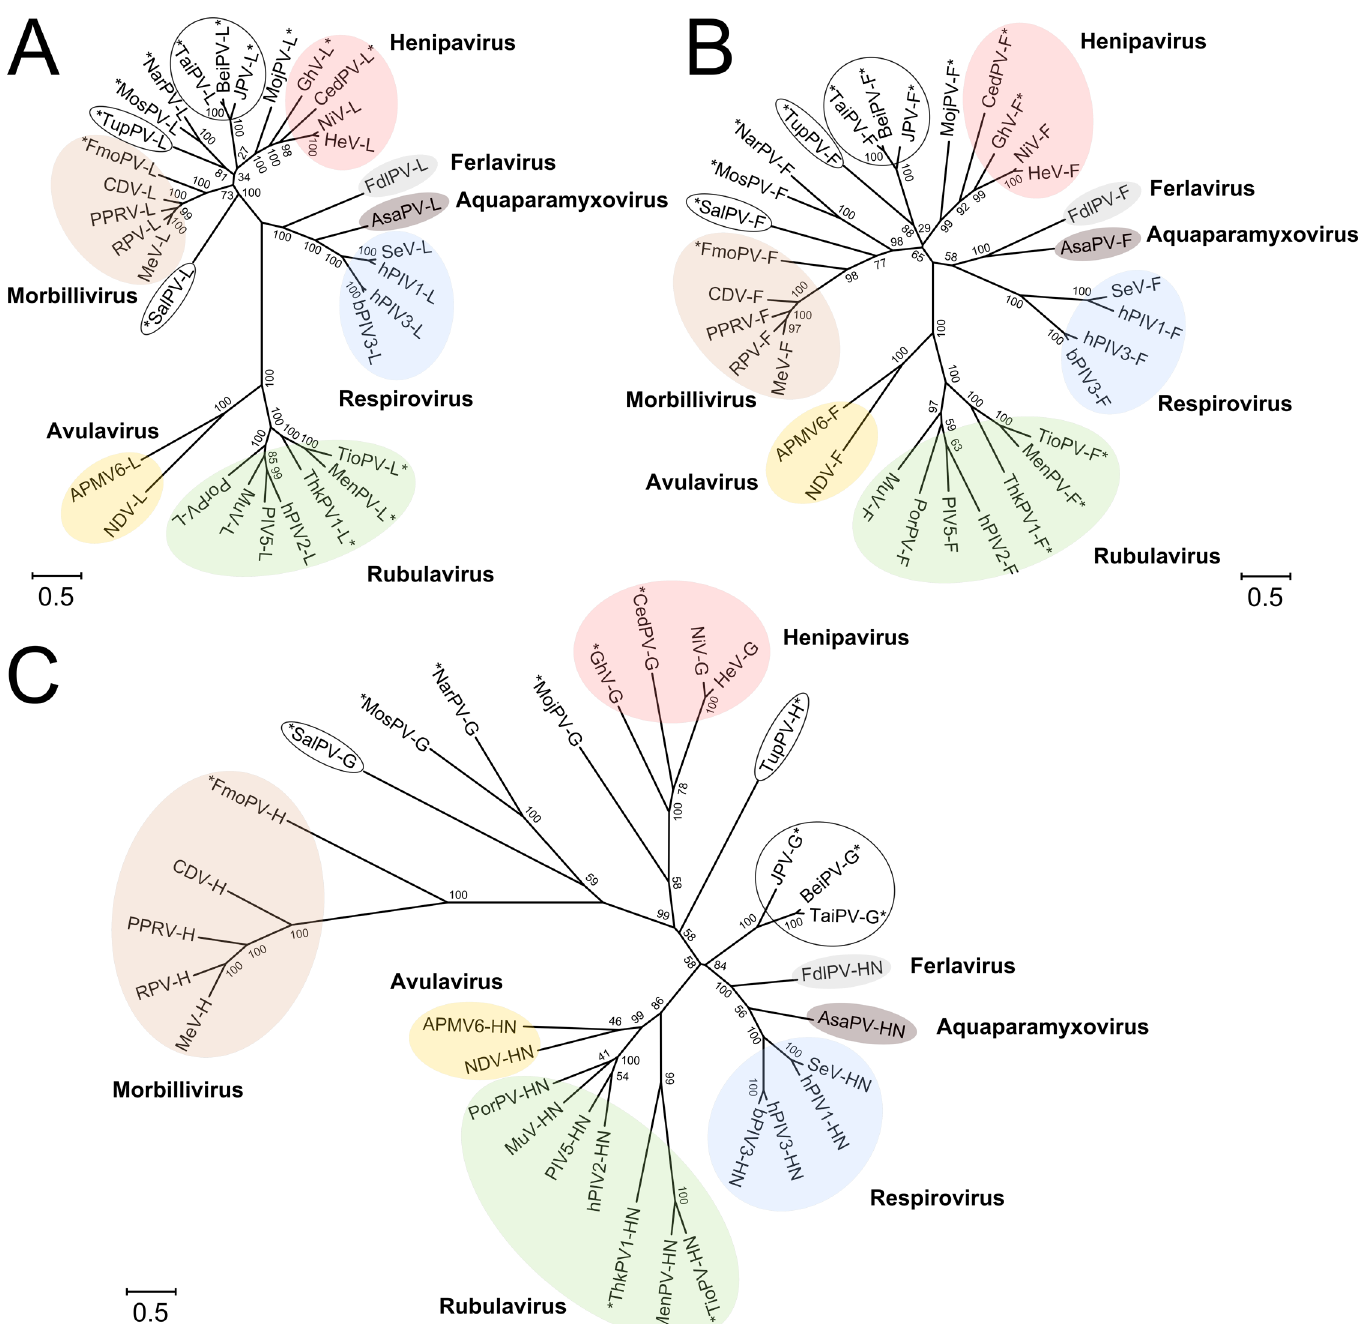
Fig 1. Maximum likelihood phylogenies of Paramyxoviridae L (A), F (B), and HN/H/G (C) protein sequences using MEGA6 (Molecular Evolutionary Genetics Analysis Version 6.0) [34], based on the LG+G+I+F model [35]. Scale bar indicates amino acid substitutions per site. Numbers at the nodes represent bootstrap values (1,000 replicates). Colored circles are used to indicate genera and empty black circles indicate viruses with varying positions between the L, F, and HN/H/G phylogenies. Uncategorized viruses awaiting taxonomic evaluation by the International Committee on Taxonomy of Viruses are marked with an asterisk. Virus names (abbreviations) and GenBank accession numbers are as follows: Mojiang virus (MojPV) NC_025352; Ghanaian bat henipavirus (GhV) HQ660129; Cedar virus (CedPV) NC_025351; Nipah virus (NiV) NC_002728; Hendra virus (HeV) NC_001906; Sendai virus (SeV) NC_001552; human parainfluenza virus 1 (hPIV1) NC_003461; human parainfluenza virus 3 (hPIV3) AY283063 (for HN) and NC_001796.2 (for L and F); bovine parainfluenza virus 3 (bPIV3) NC_002161; Tuhoko virus 1 (ThkPV1) NC_025410; Menangle virus (MenPV) NC_007620; Tioman virus